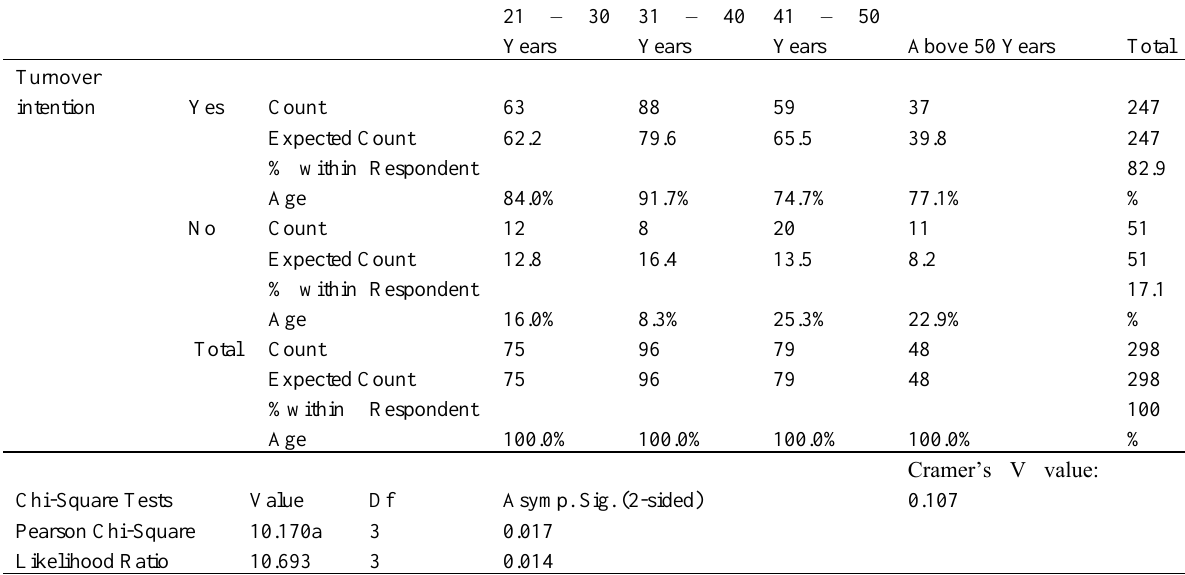
Table 5: Cross Tabulation of Turnover Intentions and Age